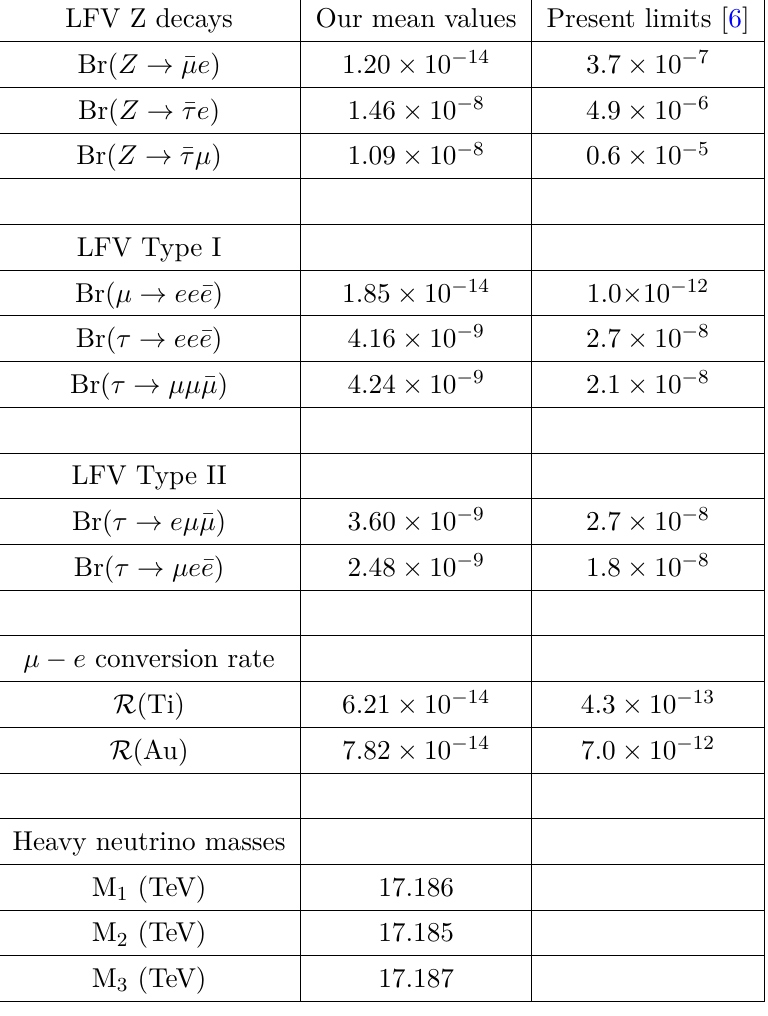
Table 2 . Mean values for branching ratios, conversion rates and three heavy neutrino masses compared to current upper limits (at 95% confidence level for the Z decays and at 90% for all other processes). Statistical errors are at the 1% level and order permille for the heavy neutrino